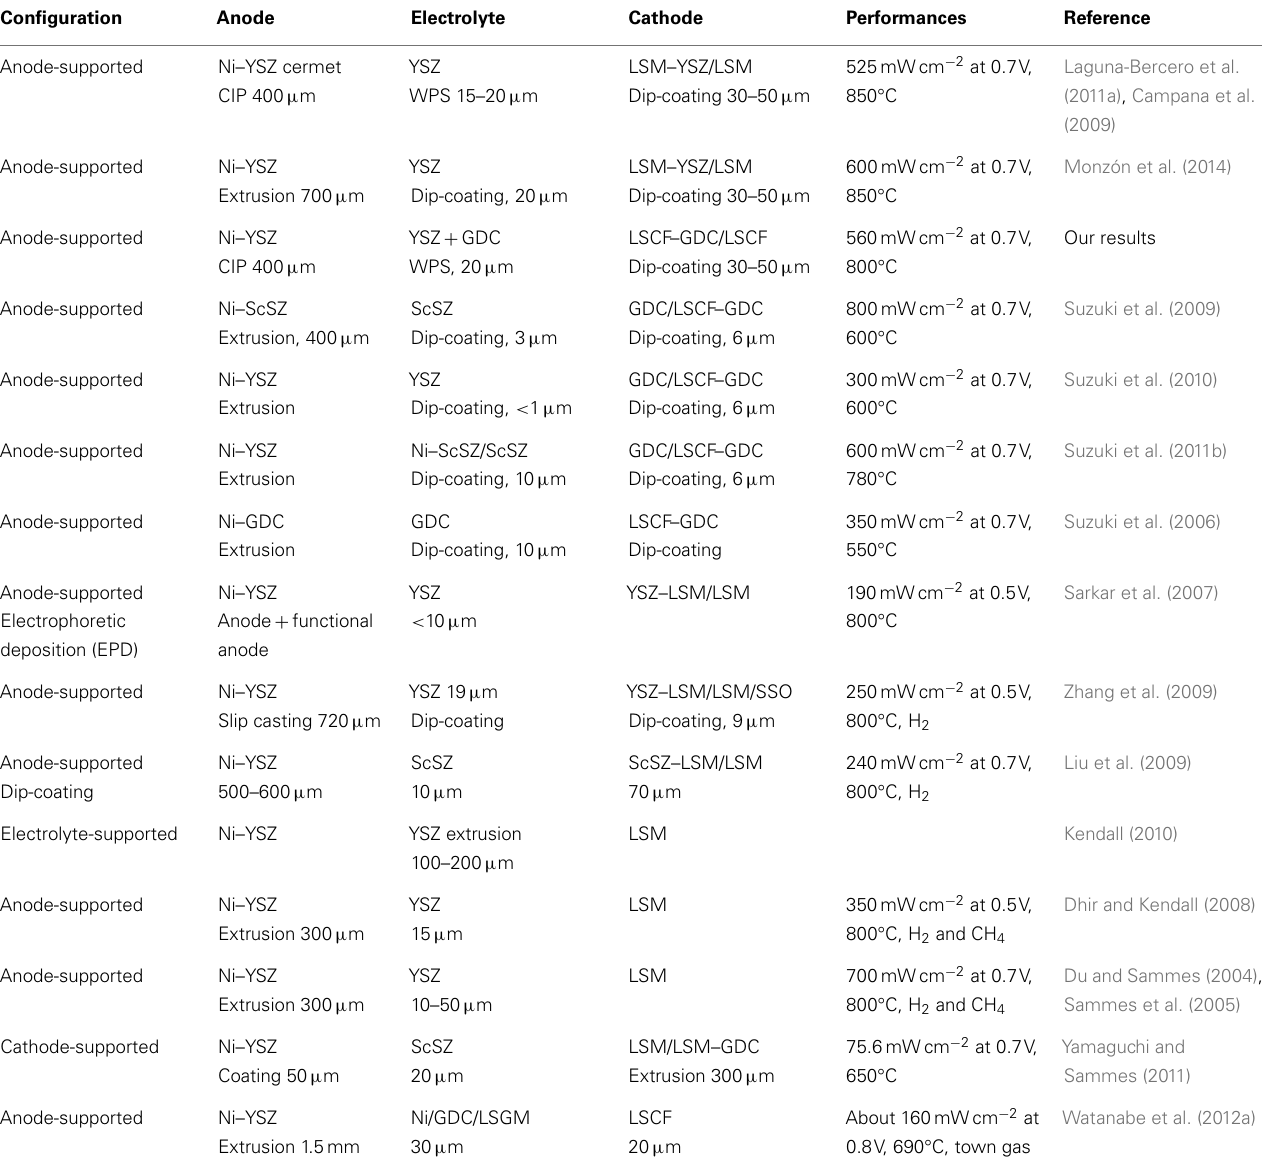
Table 4 | Description of cells produced by different groups working in mT-SOFC